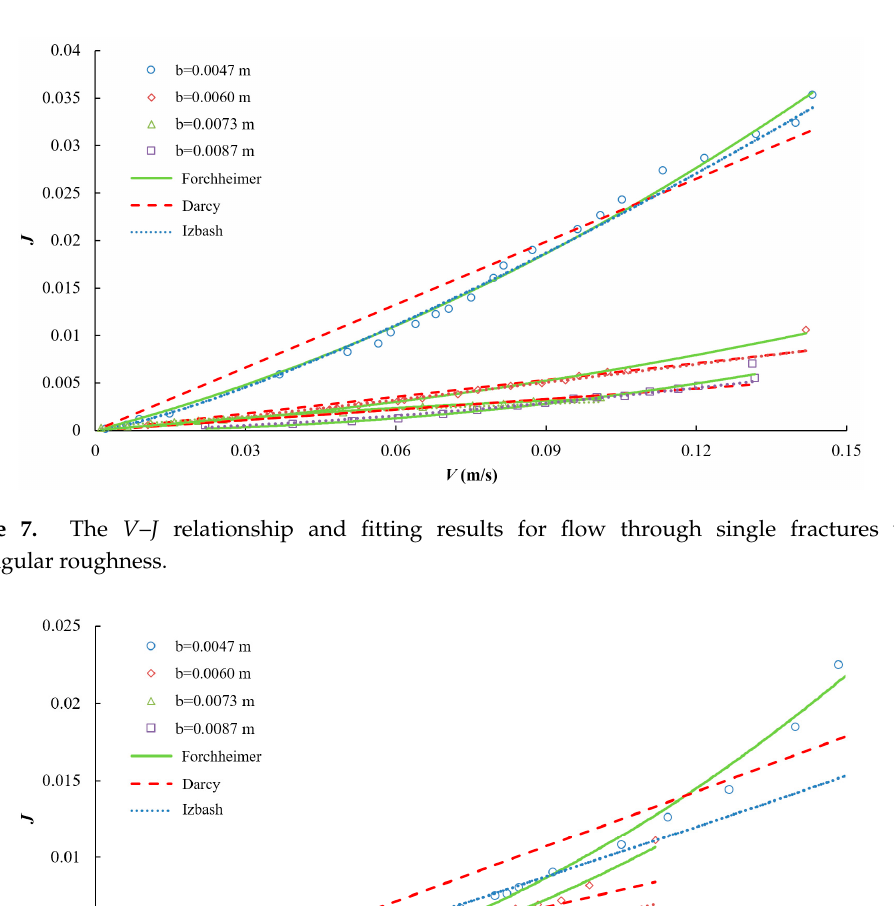
Figure 6. The V – J relationship and fitting results for flow through single fractures with smooth parallel plates.